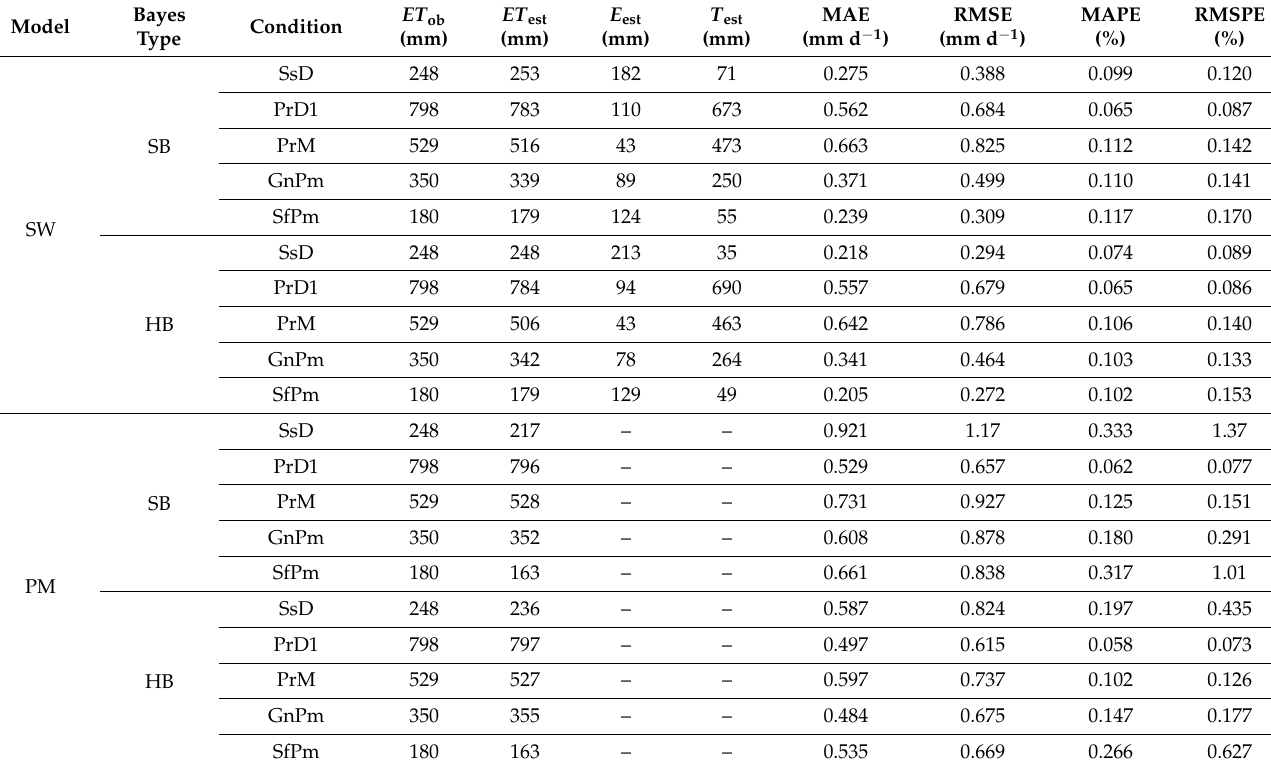
Table 3. Observed and estimated evapotranspiration ( ET ) with partitioned evaporation ( E ) and transpiration ( T ) using the Shuttleworth–Wallace (SW) and the Penman–Monteith (PM) models with parameters calibrated using simple Bayesian (SB) and hierarchical Bayesian (HB) approaches, and statistical criteria under five observation